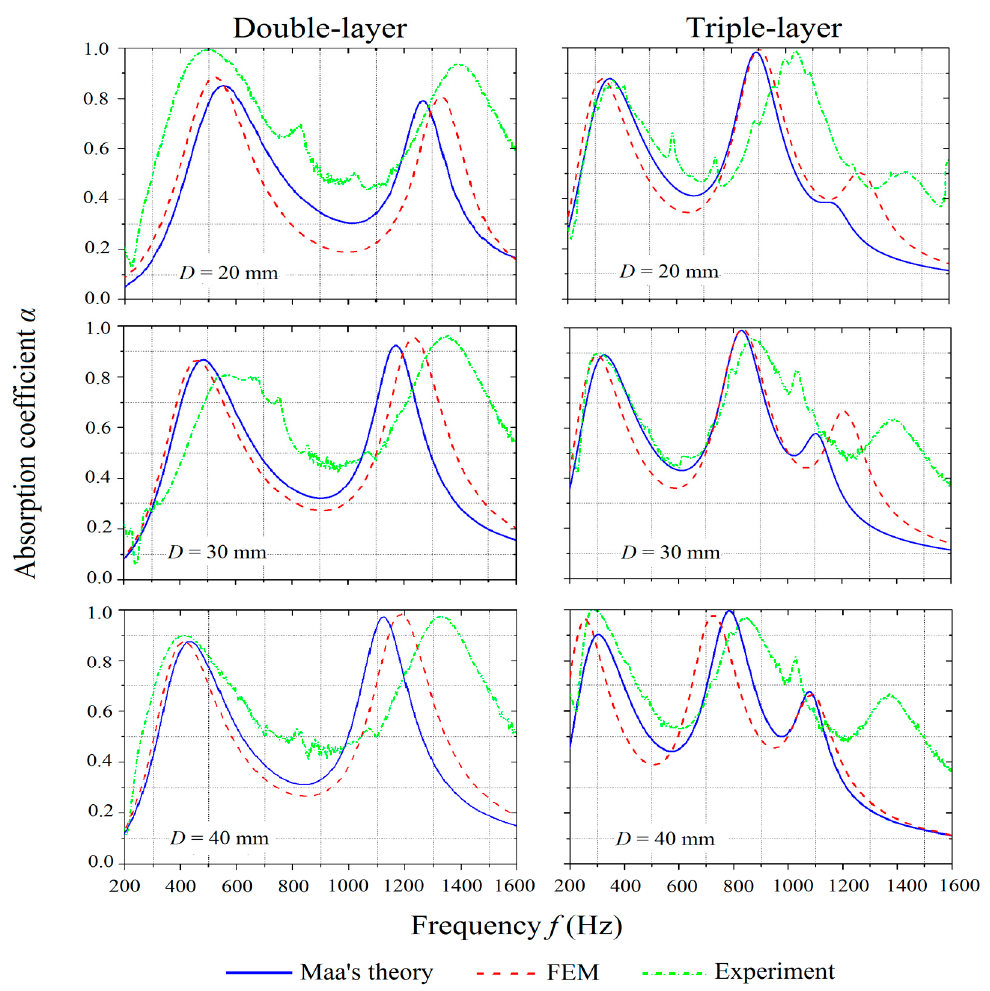
Figure 7. Comparison of absorption coefficients of MPPs with varying air gap distances obtained by the theoretical predictions, numerical simulations, and experiments.